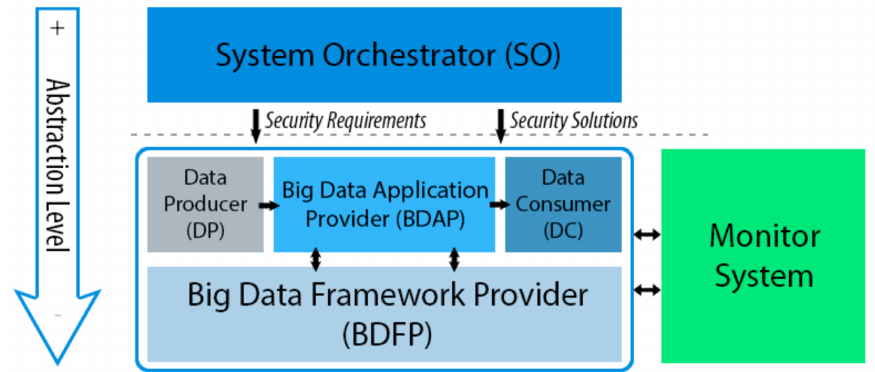
Figure 1. Main components of the security reference architectures (SRAs) for big data